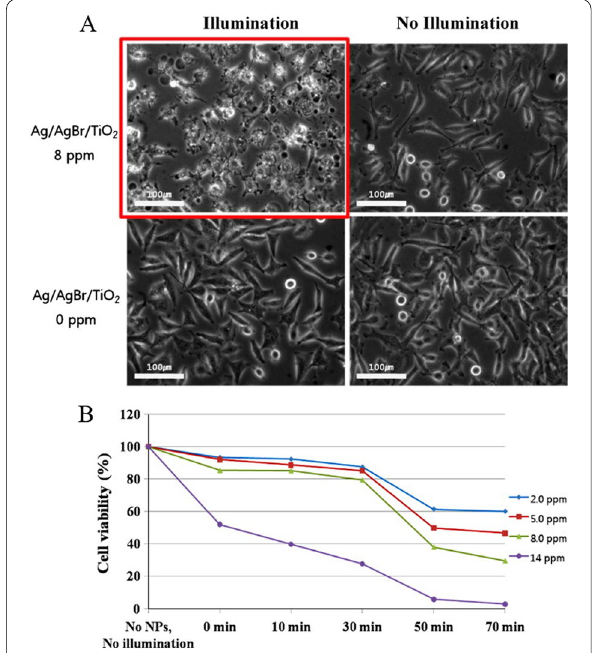
Fig. 3 A Optical inverted phase-contrast microscopy images for the viability of HeLa cells treated with Ag/AgBr/TiO 2 NPs incubated for longer than 24 h. Viability of HeLa cells as a function of halogen light illumination time. B The trypan blue exclusion test. The cells were treated with different Ag/AgBr/TiO 2 NPs concentrations in the range of 2.0, 5.0, 8.0, and 14.0 ppm. Adapted from Ref. [112] with